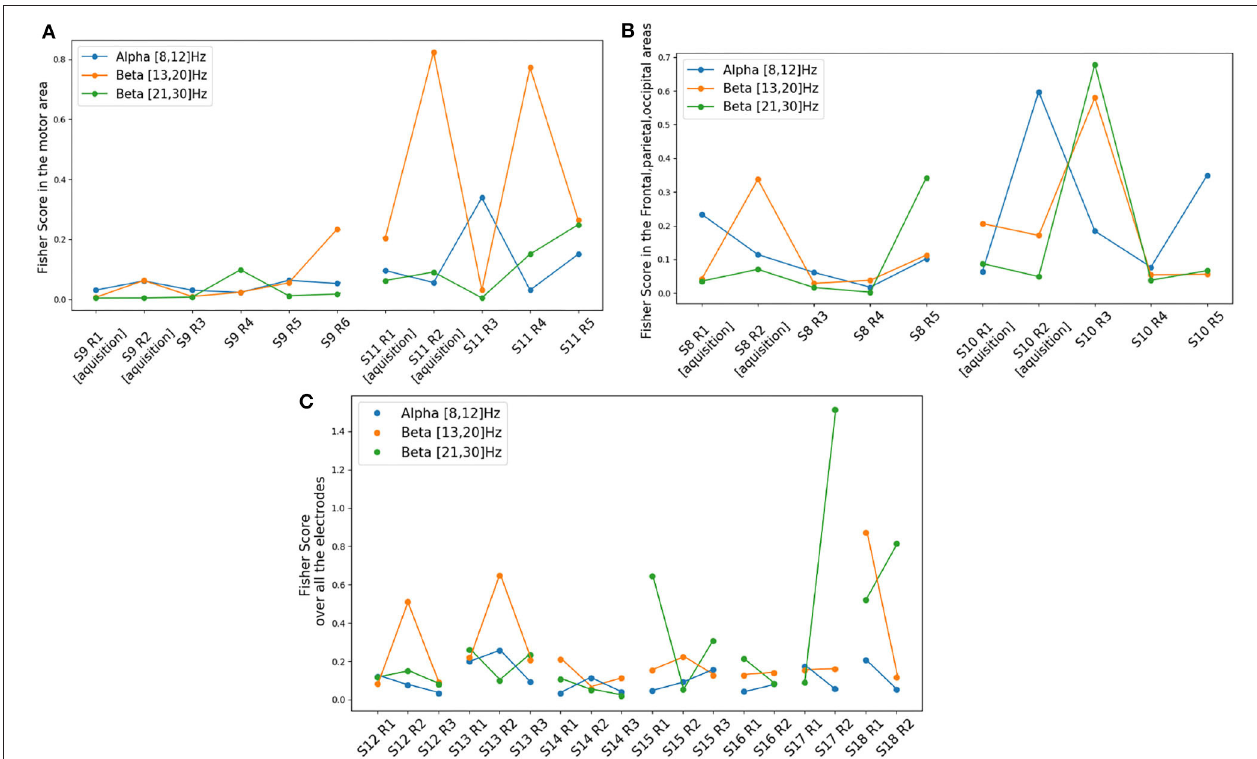
FIGURE 11 | Mean Discriminability score (Fisher Score) for each frequency band for different conditions across the sessions. In (A) : Mean FS in the motor area (2-class motor imagery BCI) for three different frequency bands. In (B) : Mean FS in the frontal, parietal and occipital areas (2-class mental task BCI, i.e., REST vs. MENTAL SUBTRACTION) for three different frequency bands. In (C) : Mean FS in all the electrodes (4-class BCI), for the three different frequency